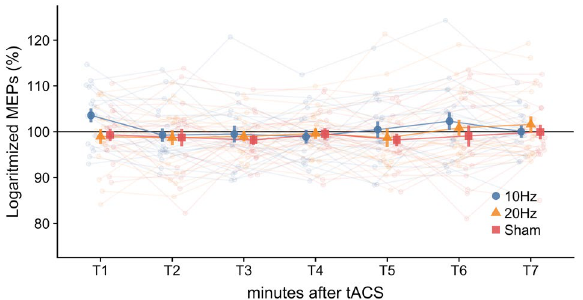
Figure 4. Time course of the primary motor excitability changes in % to the baseline for Experiment 2 (offline) for three tACS conditions (10 Hz, 20 Hz, sham) measured as logarithmized MEPs. Transparent lines represent individual dynamics of the primary motor excitability changes for each condition. Error bars indicate